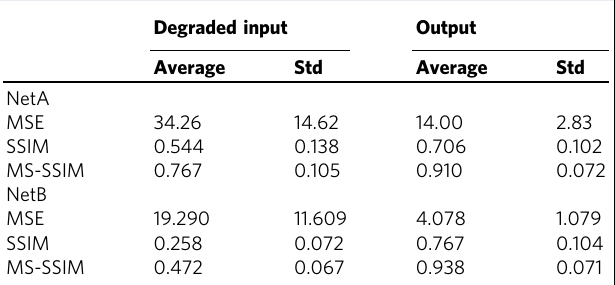
Table 1 Comparison of MSE, SSIM, and MS-SSIM of input and output for NetA and